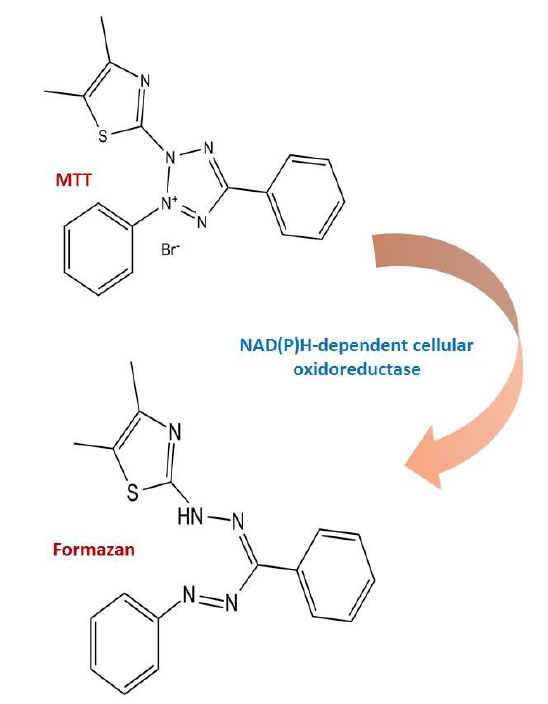
Figure 1: Flow diagram representing the systematic conversion of MTT to formazan PREPARATION OF